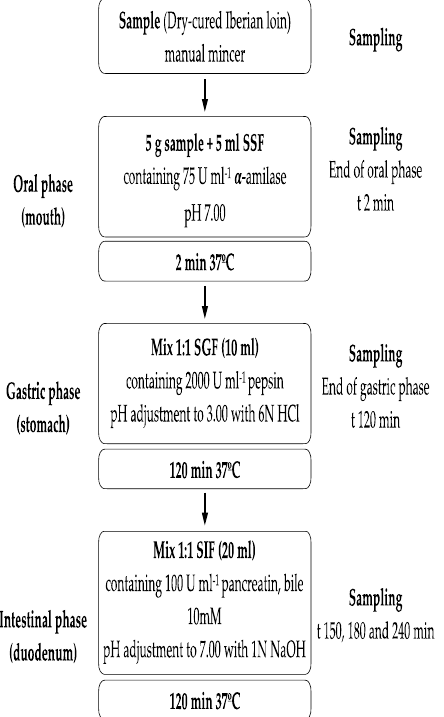
Figure 1. Flow diagram of the INFOGEST in vitro digestion method and sampling times in the experiment. Acronyms: SSF: Simulated Salivary Fluid, SGF: Simulated Gastric Fluid, and SIF: Simulated Intestinal Fluid. Enzyme activities are in units per mL of final digestion mixture at each corresponding digestion